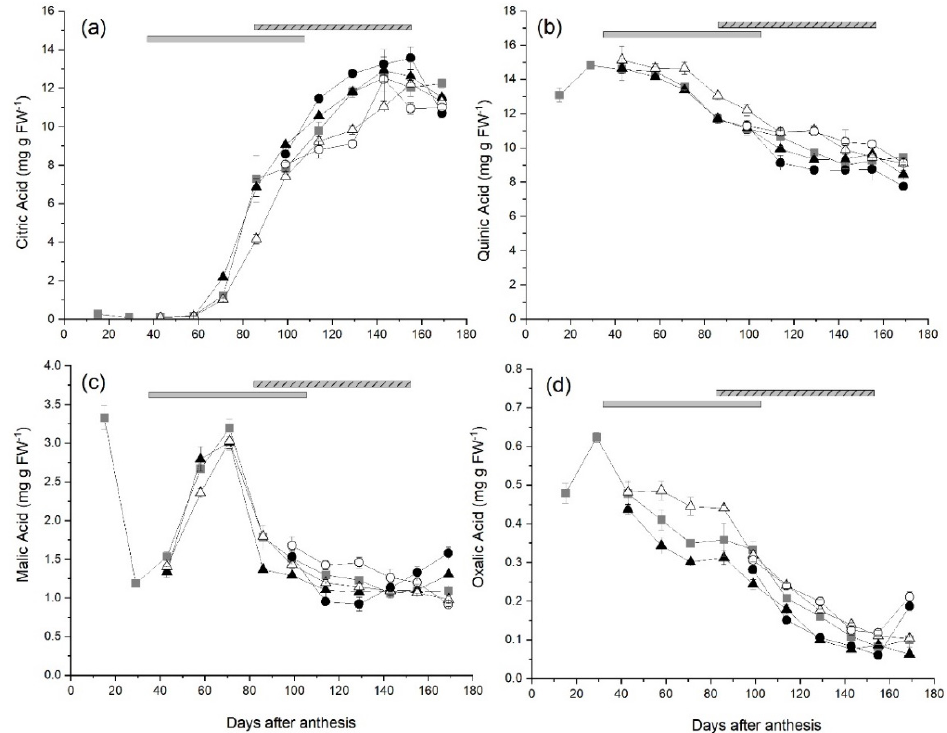
Figure 3. The effect of time of manipulation of carbohydrate supply together with phloem girdling on ( a ) citric acid ( b ) quinic acid ( c ) malic acid and ( d ) oxalic acid concentration of Actinidia chinensis var. chinensis ‘Zesy002’ kiwifruit from anthesis through to harvest. Data are shown for ungirdled control canes ( (cid:4) ), early girdled canes with high ( (cid:78) ) or low ( (cid:52) ) carbohydrate supply or late girdled canes with high ( • ) or low ( ) carbohydrate supply. Early treatments were applied at 38 days after anthesis with the duration of the open girdle shown by the grey solid bar at the top of each panel. Late treatments were applied at 86 days after anthesis with the duration of the open girdle shown by the grey/black stripped bar at the top of each panel. High carbohydrate supply treatments had six leaves per fruit, while low carbohydrate supply treatments had one or two leaves per fruit. Data are means ± SEM, n = 5.